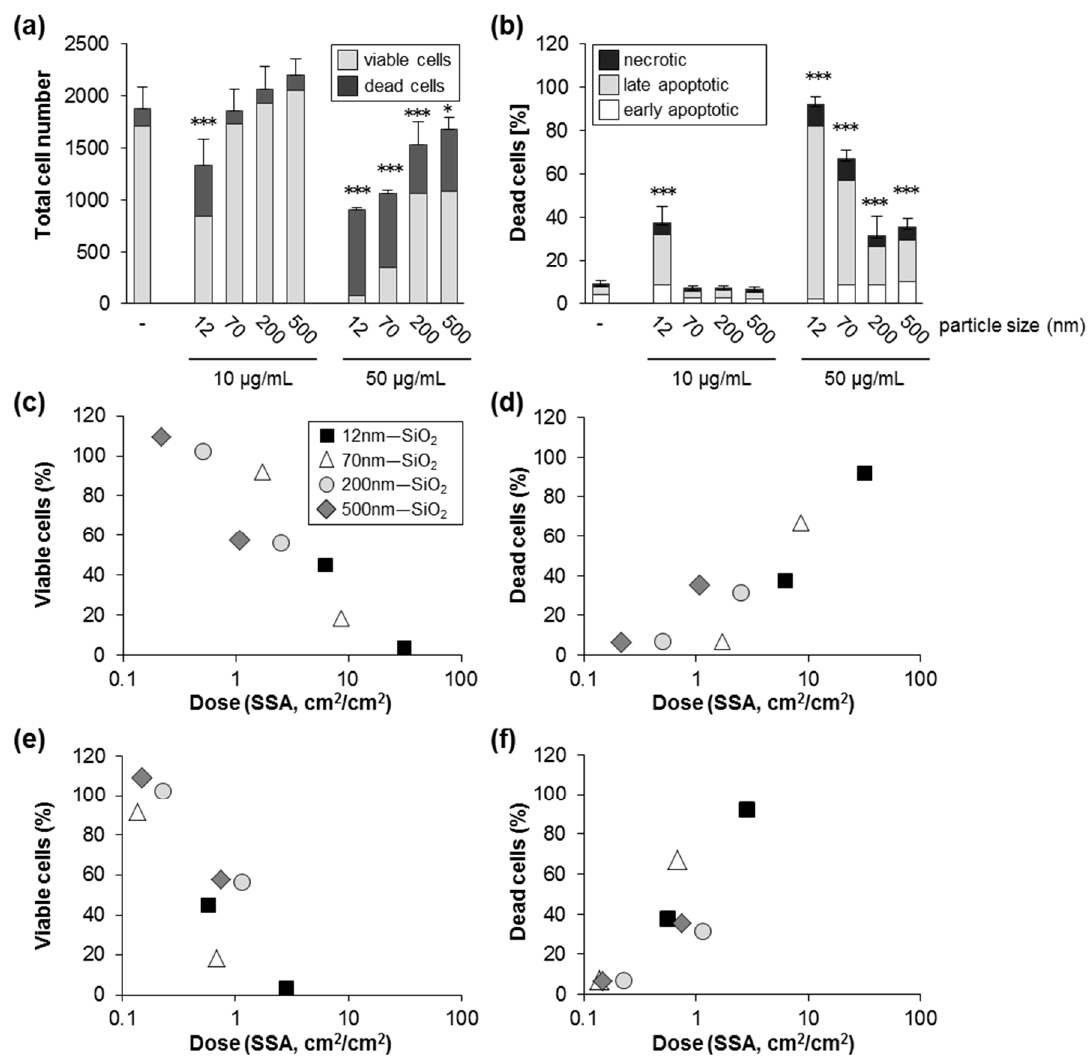
Figure 3. Silica NPs induce cell death dependent on size and specific surface area. HCT116 wt cells were incubated with particles as indicated in the absence of FBS. After 24 h, the cells were processed and analyzed as described in Figure 2. ( a ) The total cell number divided into living and dead cells. ( b ) The percentage of dead cells relative to the total cell number divided into the di ff erent classes of cell death as indicated. Data show mean values of two independent experiments carried out with four replicates ( n = 8). The error bars are SD values related to the total cell number ( a ) or the percentage of total dead cells ( b ), respectively. * p < 0.05, *** p < 0.001 indicate significant di ff erences in the response of cells treated with particles in comparison to untreated control cells (-). The percentage of viable ( c ) and dead cells ( d ) are plotted against the nominal specific particle surface area dose per cell area (cm 2 / cm 2 , logarithmic scale). For comparison ( e , f ), the calculated deposited dose has been used as a metric. Note that the nominal ( c , d ) and calculated ( e , f ) dose in case of larger particles (200 and 500 nm) were rather similar, whereas for nanoparticles (12 and 70 nm), only a small fraction was deposited. Further details are described under Methods.